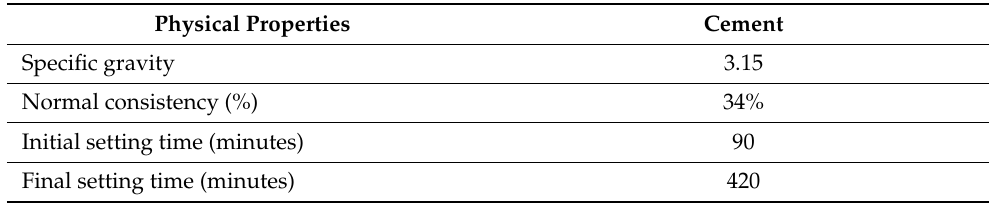
Table 1. Physical properties of cement.